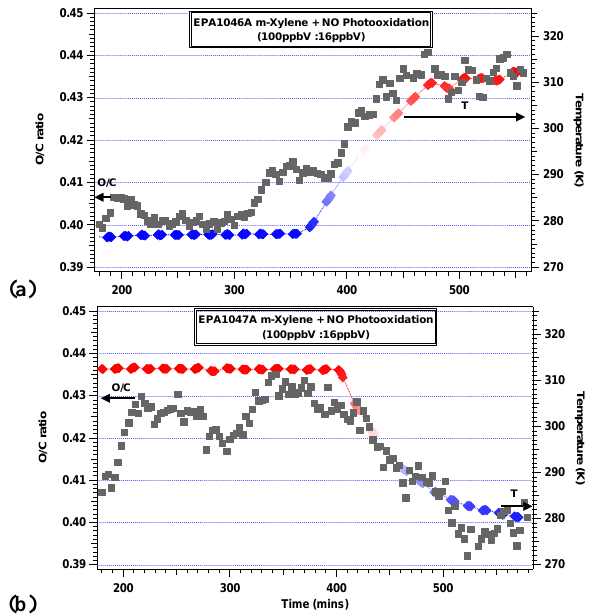
Fig.6 The time series of O/C ratio for m -xylene photooxidation experiment at cold (a: 278 K (cid:198) 313 K) and hot temperature (b: 313 K (cid:198) 278 K). The grey square represents real-time O/C ratio.